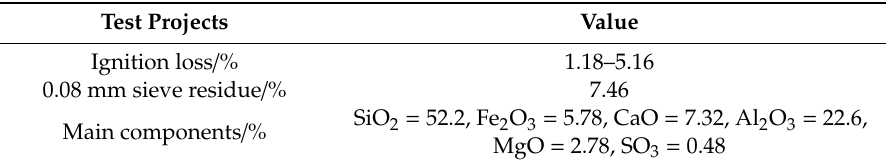
Table 2. Performance index of fly ash.